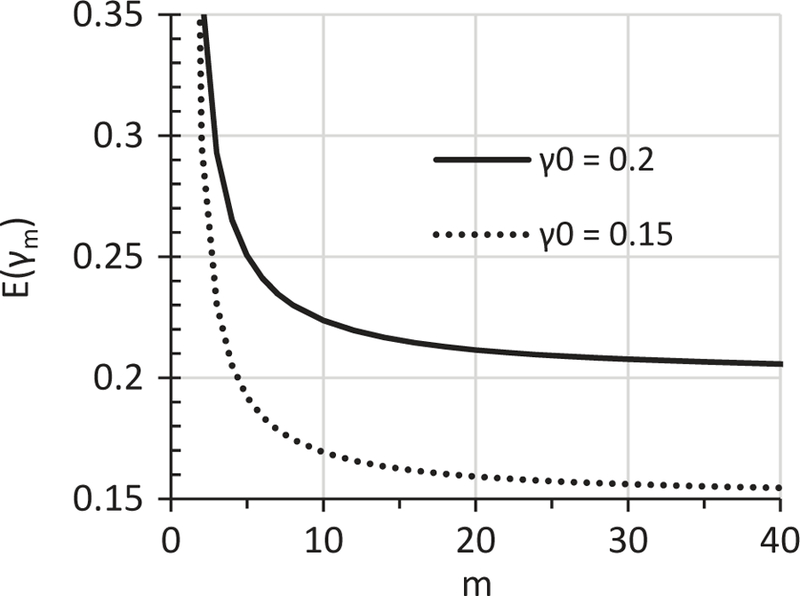
The m–E(γm) relationship curve at γ0 = 0.2 and 0.15 as determined by Equation (14).